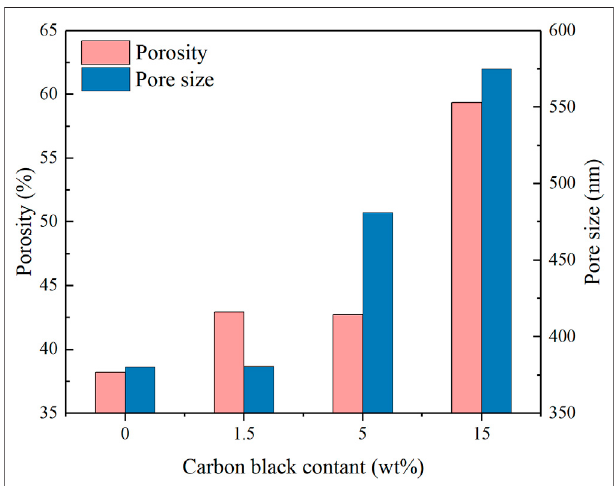
FIGURE 6 | Porosity and pore size with different carbon black contents.